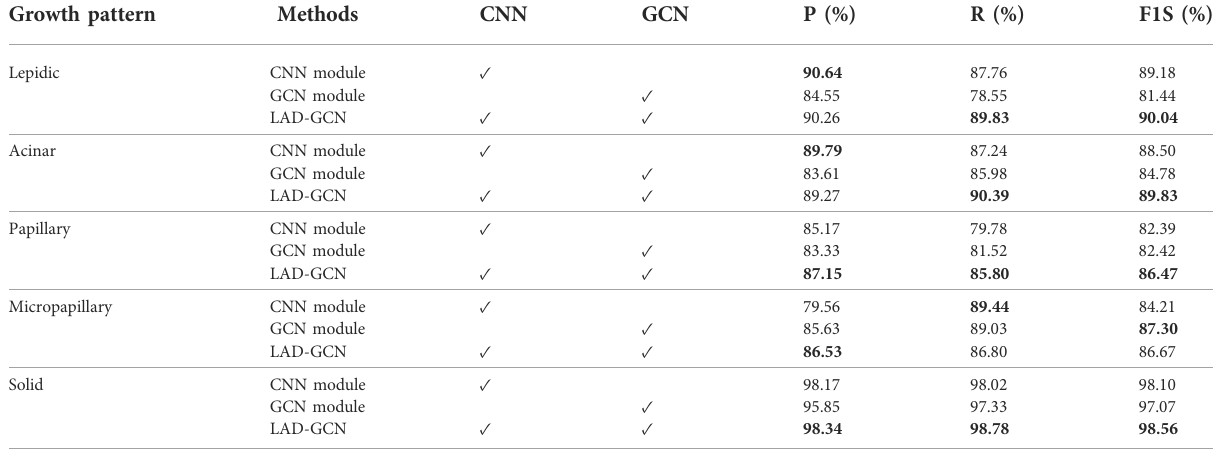
TABLE 1 Effects of each module in our LAD-GCN design. Bold font indicates best result obtained for predictions. Growth pattern